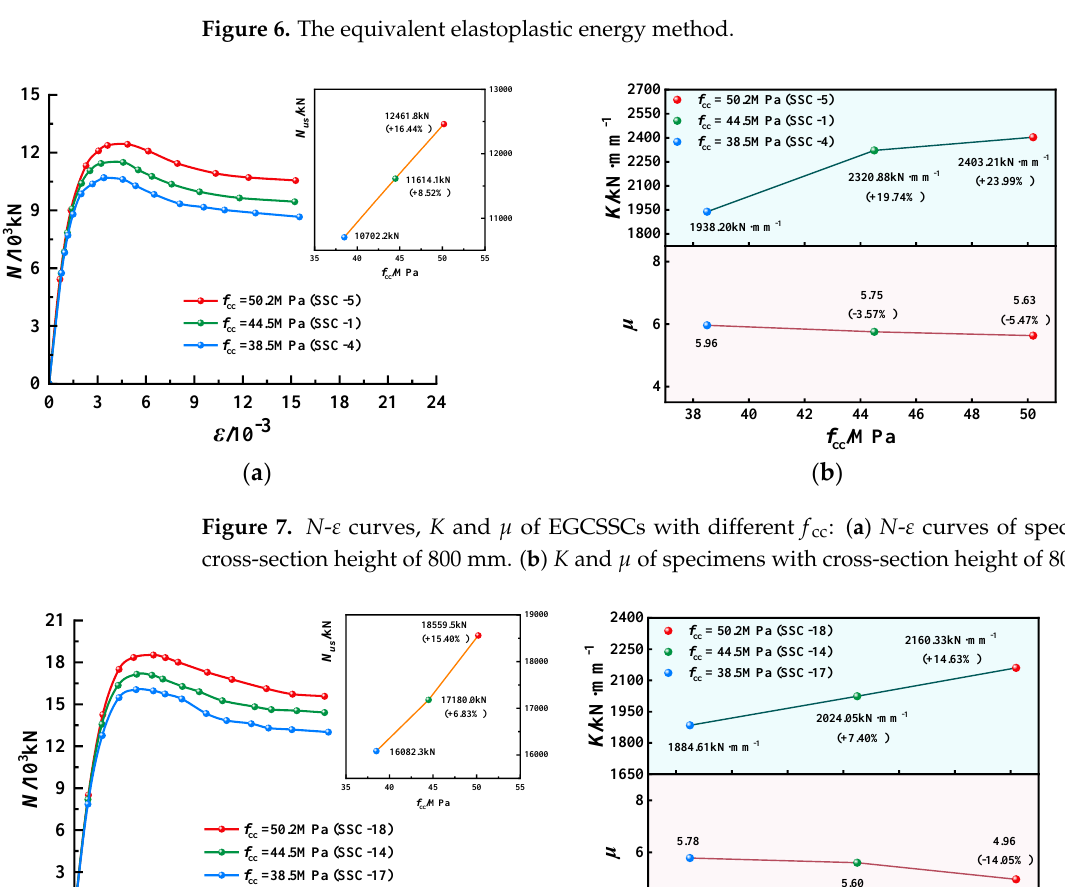
Figure 6. The equivalent elastoplastic energy method.